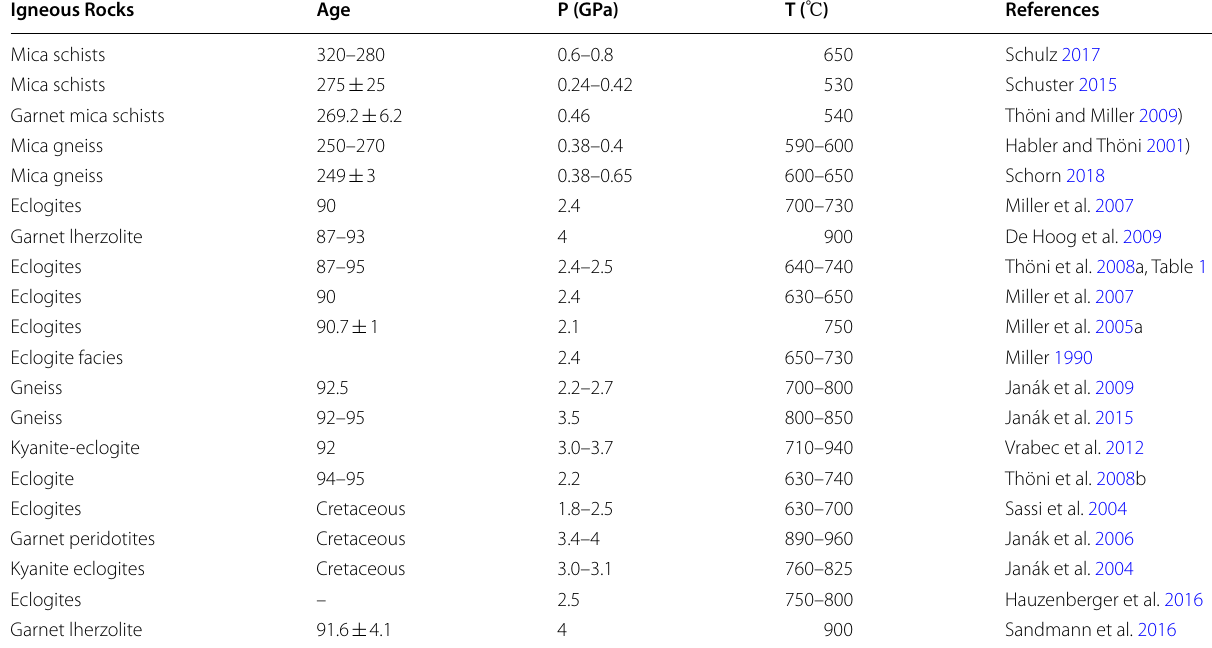
Table 4 P-T conditions of EGU from previous research Igneous